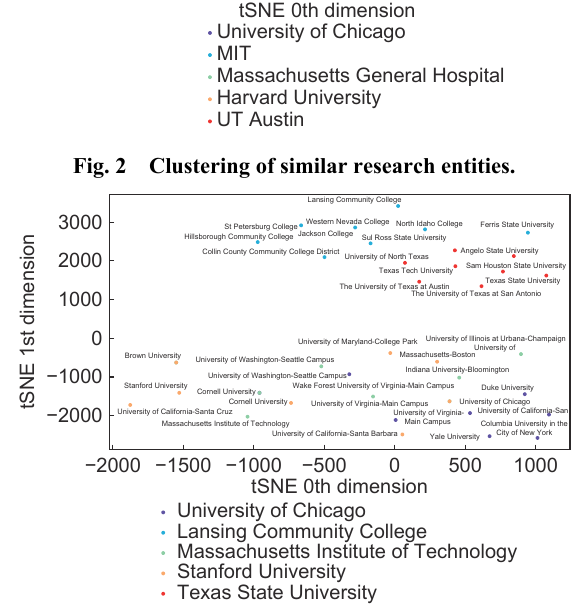
Fig. 3 Clustering of similar teaching entities.